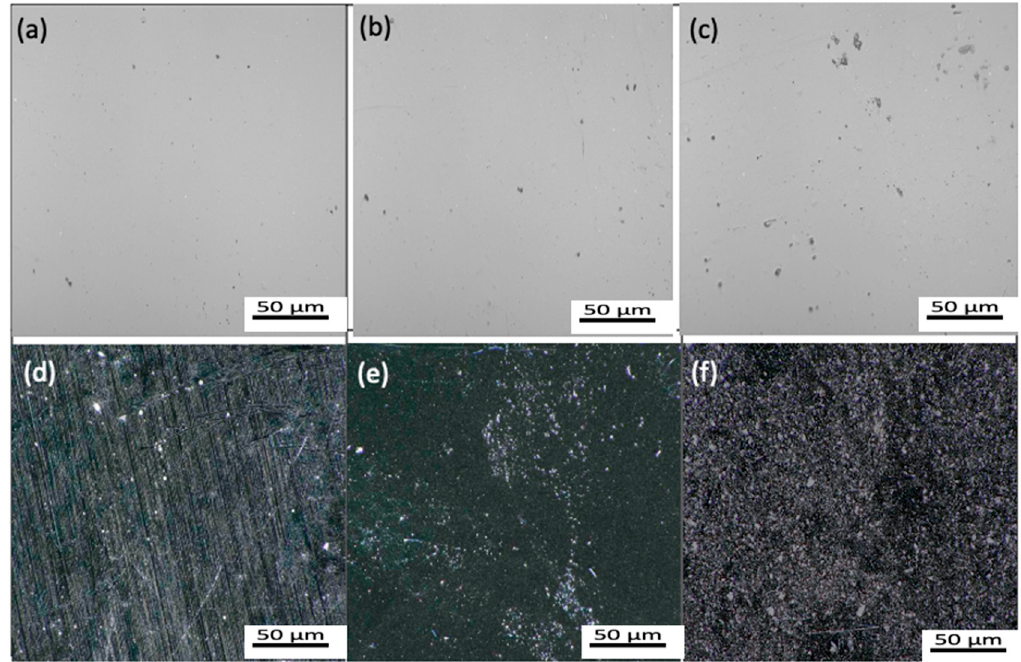
Figure 4. OM images of the dispersion morphology of ( a ) C750 Gnp/epoxy, ( b ) M15 Gnp/epoxy and ( c ) X50 Gnp/epoxy and SM images of ( d ) C750 Gnp/epoxy, ( e ) M15 Gnp/epoxy and ( f ) X50 Gnp/epoxy composite coatings.